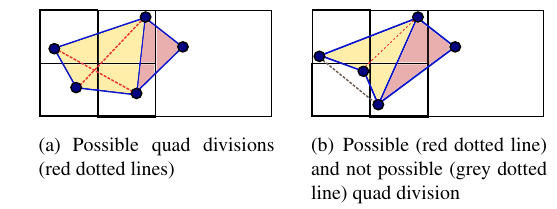
(a) Possible quad divisions (b) Possible (red dotted line) (red dotted lines) and not possible (grey dotted line) quad division Figure 5. Quads (yellow areas) and triangles (red areas) resulting from connecting adjacent hyperpoint vertices (dark blue points) to 3D edges (blue lines, top